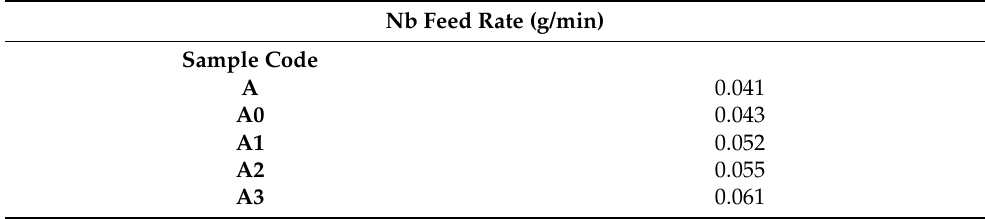
Table 2. Sample code and the Nb feed rate applied in developing Ti-Al based